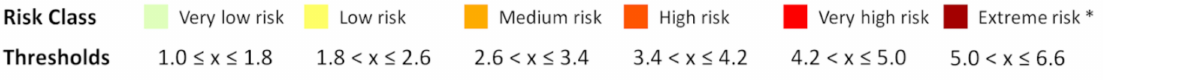
Figure 1. The WWF Water Risk Filter Risk’s risk classes and respective thresholds. * The “extreme risk” class is only applied in the case of future